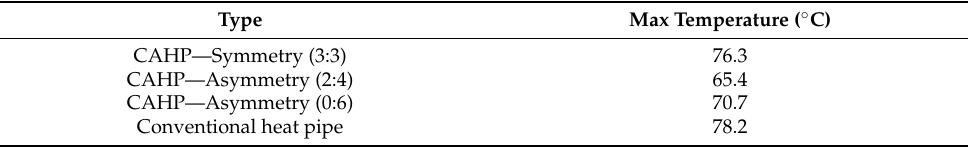
Figure 13. Comparison of different heat pipes with different sectorial condensers by 2D simulation. Table 4. Temperature in each condition. Table 4. Temperature in each